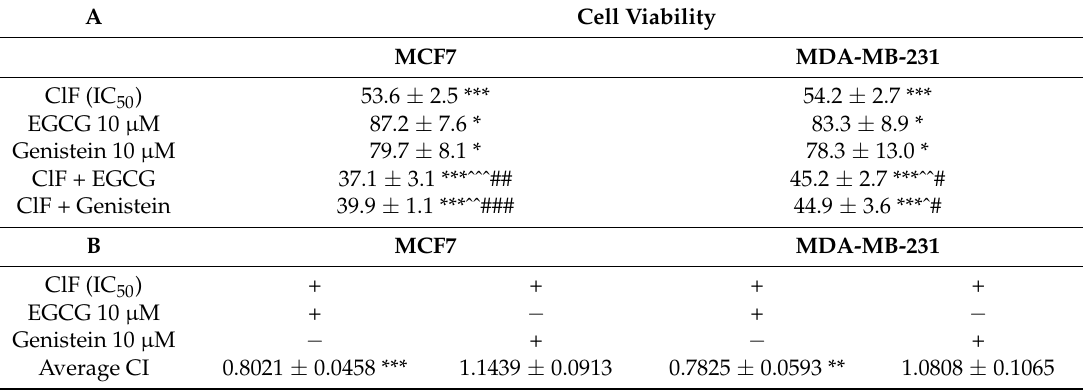
Table 1. Effects of ClF at IC 50 concentration (640 nM and 50 nM in MCF7 and MDA-MB-231 cells, respectively), EGCG or genistein at 10 µ M concentration, as well as ClF (IC 50 ) in combination with EGCG or genistein (10 µ M) on MCF7 and MDA-MB-231 cell viability ((viable exposed/viable